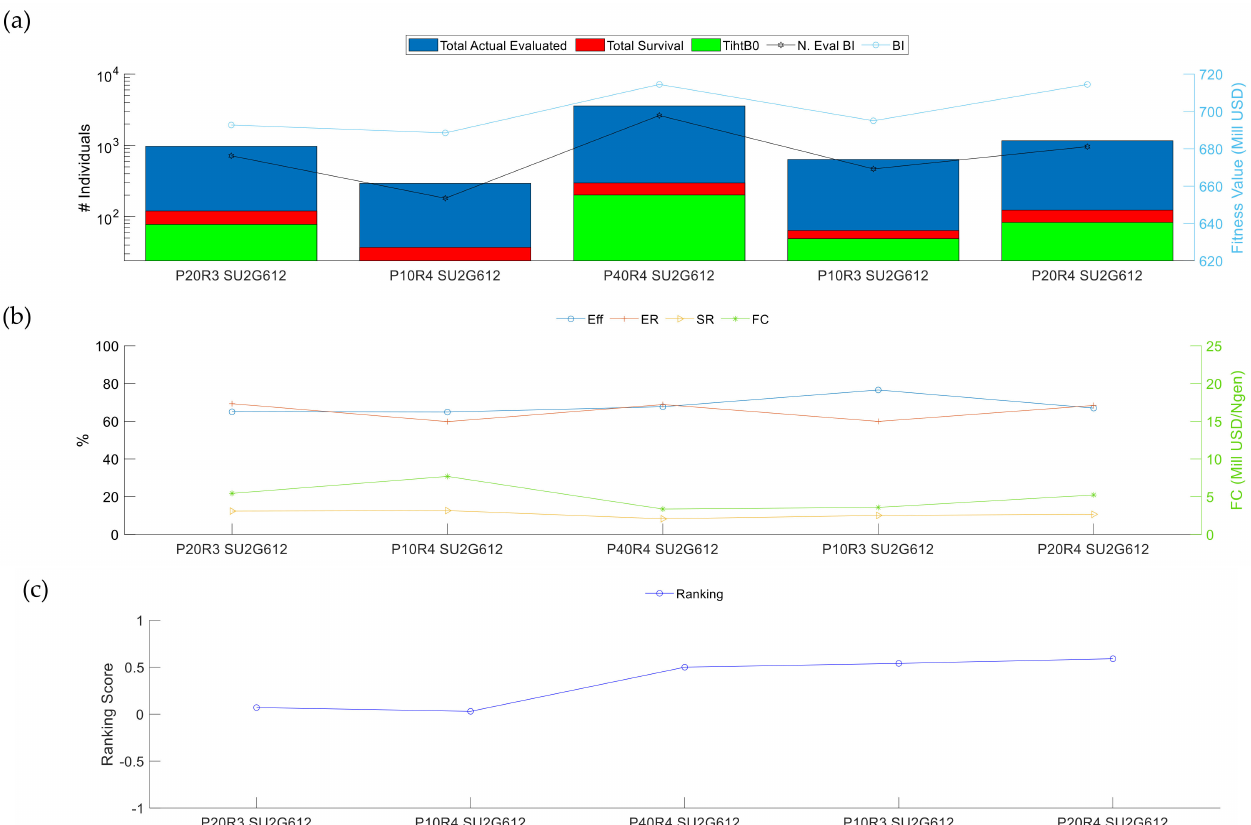
Figure 27. Summary of the performance indicators comparing POP xxR3 vs. POP xxR4. ( a ) shows variables of KPI 3,4 and 5 in bar chart, KPI 1 and variable of KPI 7 in line chart, ( b ) shows KPI 3,4,5 and 6 in line chart, ( c ) shows the ranking score based on Table